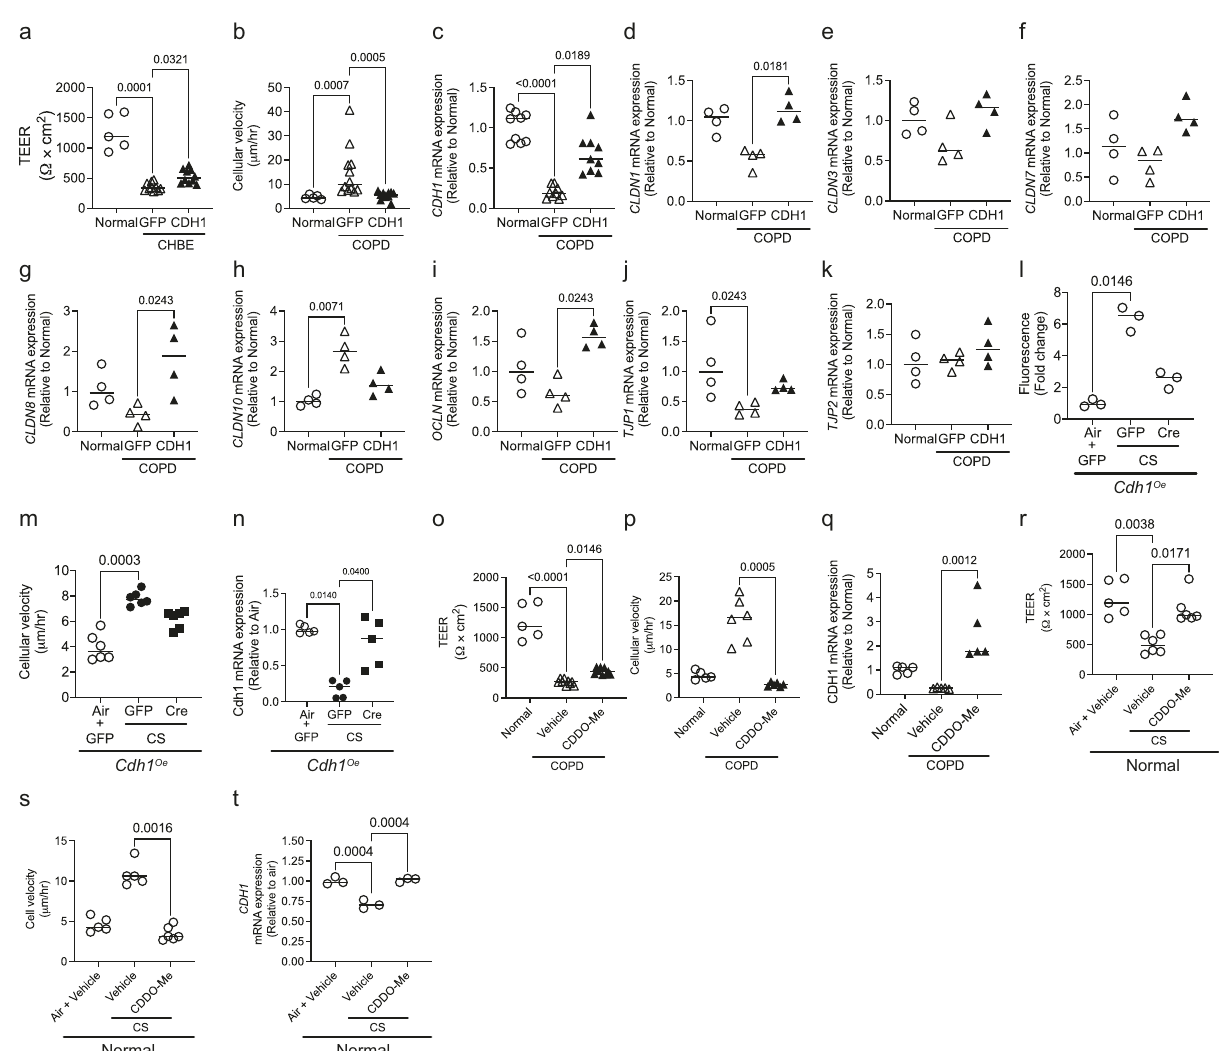
Fig. 7 In vitro overexpression of E-cadherin or by activating the Nrf2 pathway protects E-cadherin expression and restores epithelial function in COPD and cigarette smoke (CS) injured epithelia. COPD cells at 4 to 6 weeks ALI were transfected Ad-GFP-U6-h-CDH1 (CDH1) to overexpress E-cadherin or Ad-GFP (GFP) as control at 2 × 10 9 pfu. COPD cells transfected with Ad-CDH1 result in a increased epithelial resistance, b reduced cellular velocity of COPD cells, and c increased mRNA expression of CDH1 . Overexpression of E-cadherin in COPD cells d – g increased mRNA expression of claudins — CLDN1 , CLDN3 , CLDN7 , and CLDN8 , h decreased mRNA expression of CLDN10, i increased mRNA expression of occludin (OCLN), j increased mRNA expression of tight junction protein 1 (TJP1), and k TJP2 was not altered. Data is expressed as median bars and generated from 4 to 12 transwells per condition from two donors. To induce the over-expression of E-cadherin in Cdh1 knock-in mice, mice tracheal epithelial cells (mTECs) were transfected with adeno-Cre (Ad5CMVCre-eGFP) at 2 × 10 9 pfu and were exposed to CS for 10 days. Overexpression of E-cadherin in mTECs protects against CS-induced epithelial functional phenotypes by l decreasing monolayer permeability, m decreasing the cellular velocity, and n protecting Cdh1 mRNA downregulation due to CS exposure. Data for l – m involves three to six transwells per condition. COPD cells treated with CDDO-Me restore epithelial function by o improving the epithelial resistance, p decreasing the cellular velocity, and q increasing the CDH1 mRNA expression of COPD cells as compared to age and gender- matched non-diseased epithelium (normal controls). Similarly, cigarette smoke (CS) exposed to healthy normal cells treated with CDDO-Me r restores epithelial resistance, s decreases cellular velocity, and t protects against CDH1 mRNA downregulation due to CS exposure. (Data for o – t is generated from 3 to 6 transwells from 2 donors). For the panels the same data for normal are used for a – k , and o – t in the fi gure. Data are expressed as median bars. Kruskal- Wallis test, followed by Dunn ’ s multiple comparison test was performed . P < 0.05 were considered statistically signi fi